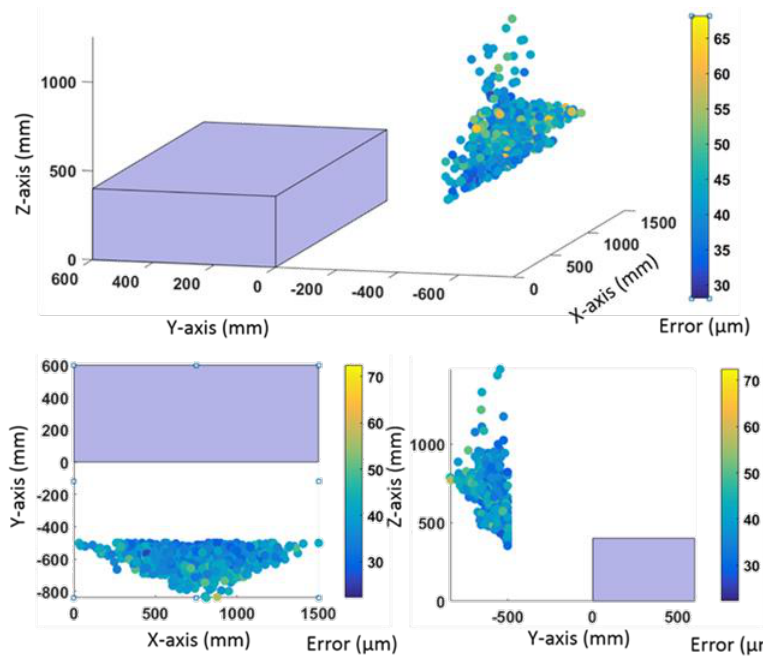
Figure 6. Error and LT location area in the wide zone using a laser–residual error.